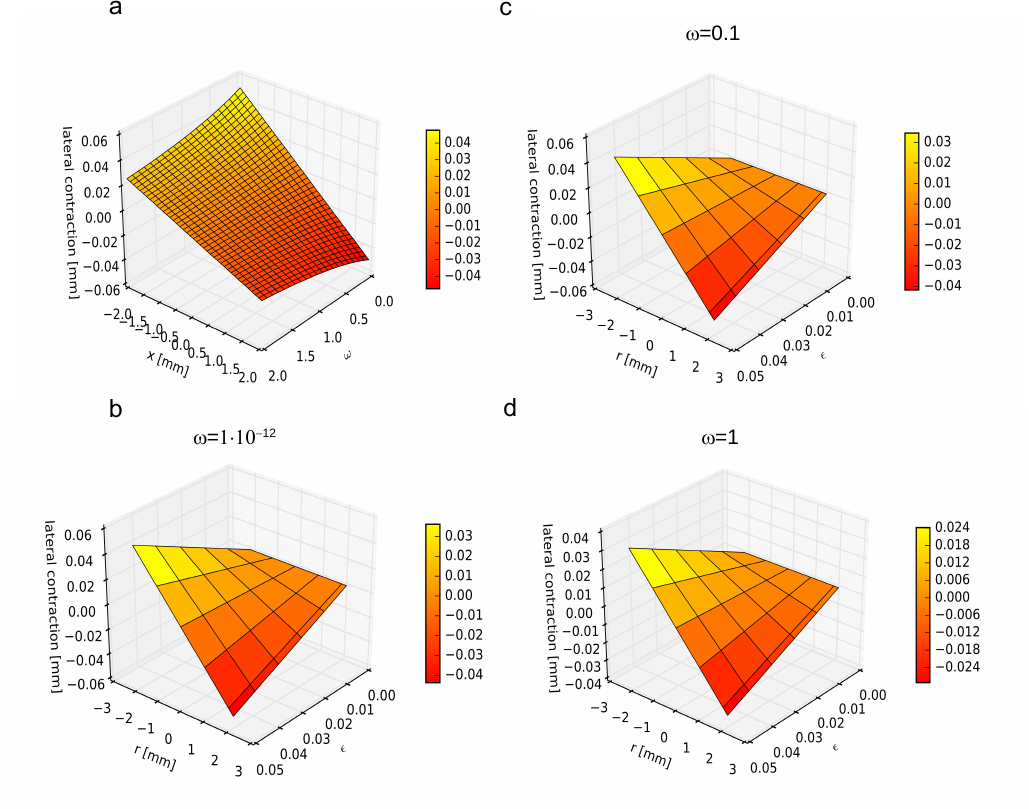
Figure 4. ( a ) Evolution of the lateral contraction with the variation of the distance from the center of nerve section for the maximum strain ( (cid:101) = 0.05) and 0 < ω ≤ 2. ( b ) Evolution of the lateral contraction with the variation of the distance from the center of nerve section for 0 ≤ (cid:101) ≤ 0.05 and ω = 1 × 10 − 12 (fully incompressible solid). ( c ) Evolution of the lateral contraction with the variation of the distance from the center of nerve section for 0 ≤ (cid:101) ≤ 0.05 and ω = 0.1 (nearly incompressible solid). ( d ) Evolution of the lateral contraction with the variation of the distance from the center of nerve section for 0 ≤ (cid:101) ≤ 0.05 and ω = 1 (compressible